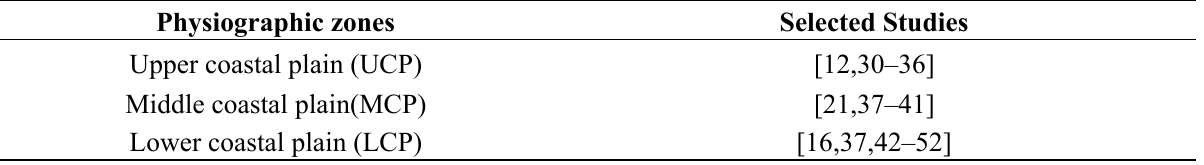
Table 1. Physiographic distribution of 26 selected studies that provided data for the herbaceous richness model of the pine forests of the southeastern coastal